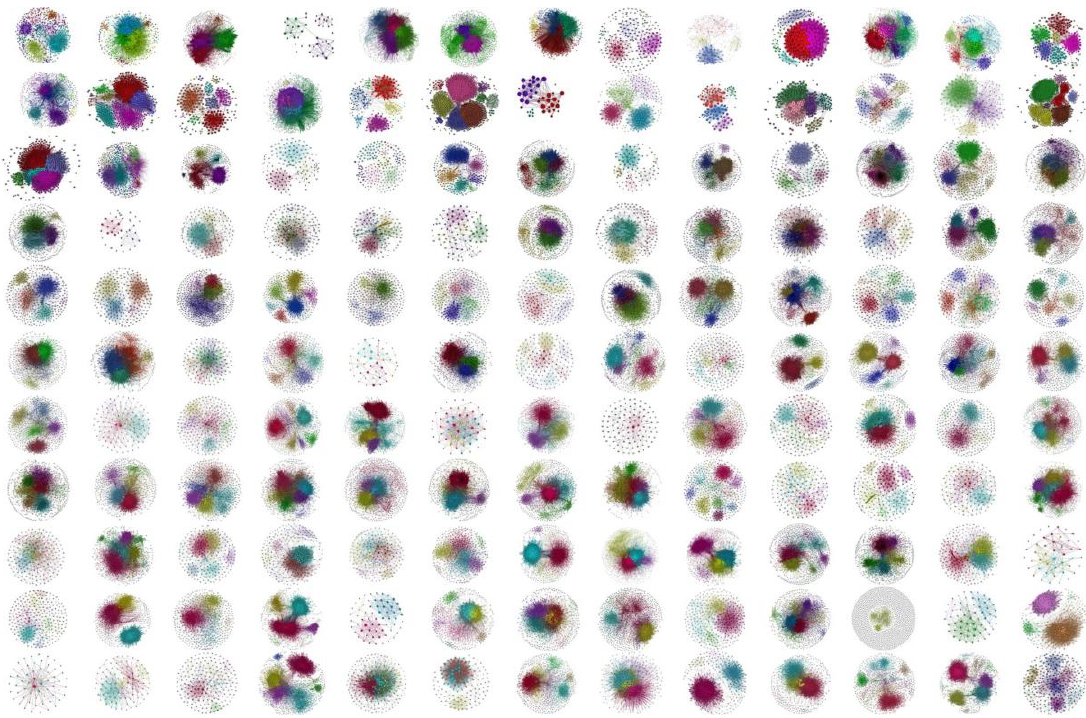
Figure 1. The participants’ individual Facebook networks. Note: Each node represents a single Facebook contact, and each edge represents a connection between two Facebook contacts. Network subgroups (as identified by NameGenWeb) are illustrated in different colors.